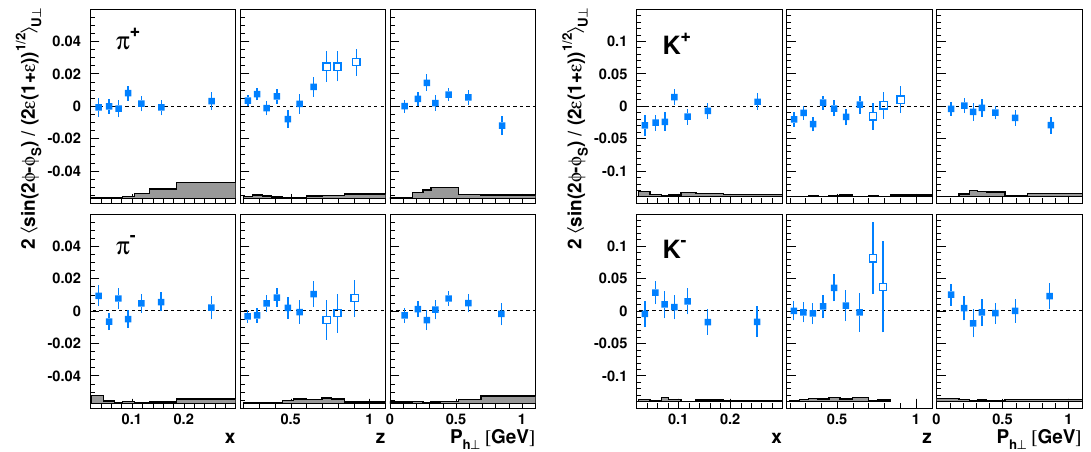
p Figure 23 . The 2 h sin(2 φ − φ S ) / 2 (cid:15) (1+ (cid:15) ) i h amplitudes for charged mesons (left: pions; right: U ⊥ kaons) presented either in bins of x , z , or P h ⊥ . Data at large values of z , marked by open points in the z projection, are not included in the other projections. Systematic uncertainties are given as bands, not including the additional scale uncertainty of 7.3% due to the precision of the target- polarization